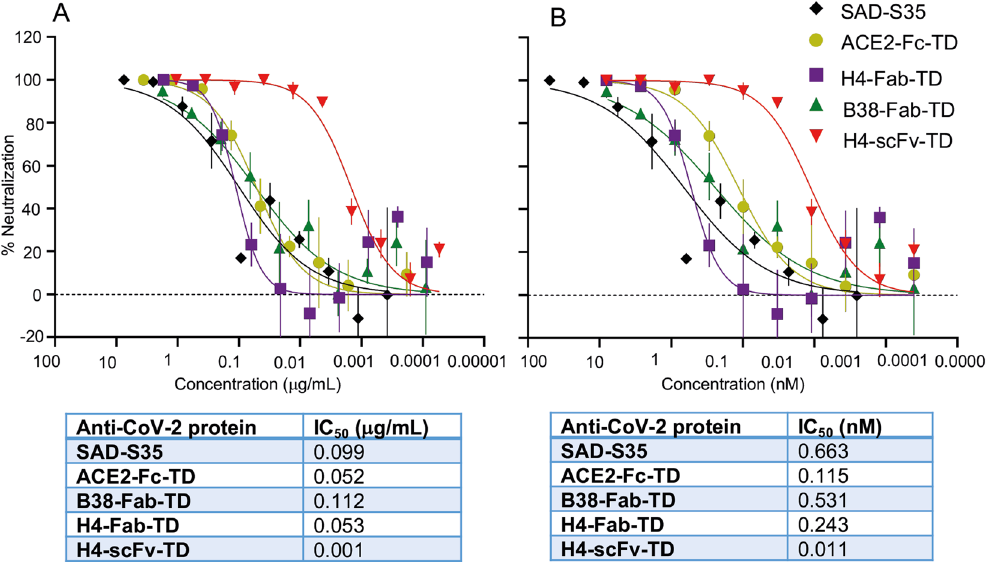
Figure 4. Tetramerized H4 and B38 anti-SARS-CoV-2 antibodies are potent inhibitors of virus infection. The viral infection neutralizing potency of tetrameric versions of the mAbs H4 and B38 was examined in SARS- CoV-2 pseudovirus infection assays. Increasing concentrations of H4-scFv-TD, H4-Fab-TD or B38-Fab-TD were incubated with HEK 293 T/17-A2-T2 cells after 1 h. The cells were incubated for 60 h before luciferase activity, indicative of viral entry, was determined. The efficacy was compared to the neutralization effects of a commercial anti-SARS-CoV-2 mAb SAD-S35 (AcroBiosystems) and a tetramerized ACE2-Fc-TD. Data are represented in µg/mL (A) and nM (B) . Calculated IC 50 values are tabulated below each set of curves. The assays were performed twice, in duplicate with error bars indicating the standard